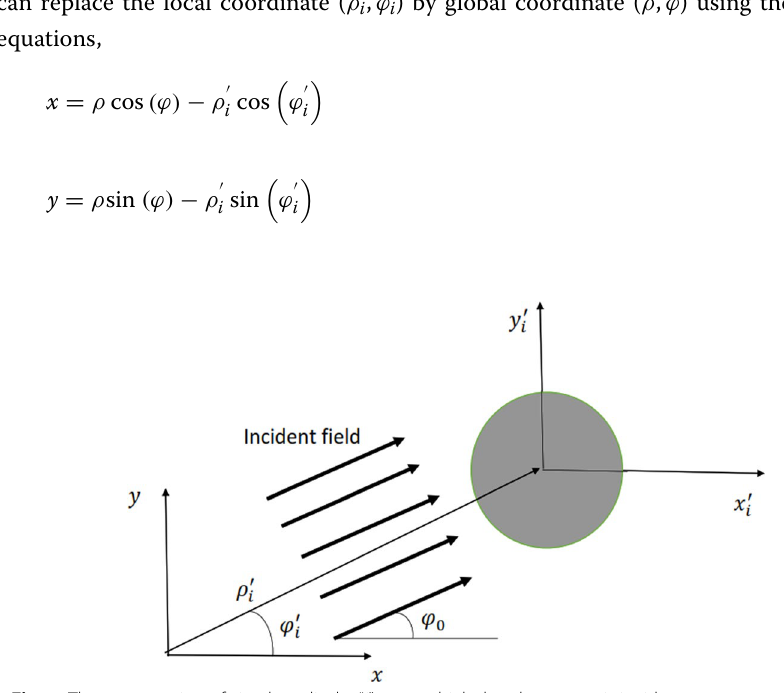
Fig. 1 The cross section of circular cylinder “ i ” upon which the plane wave is